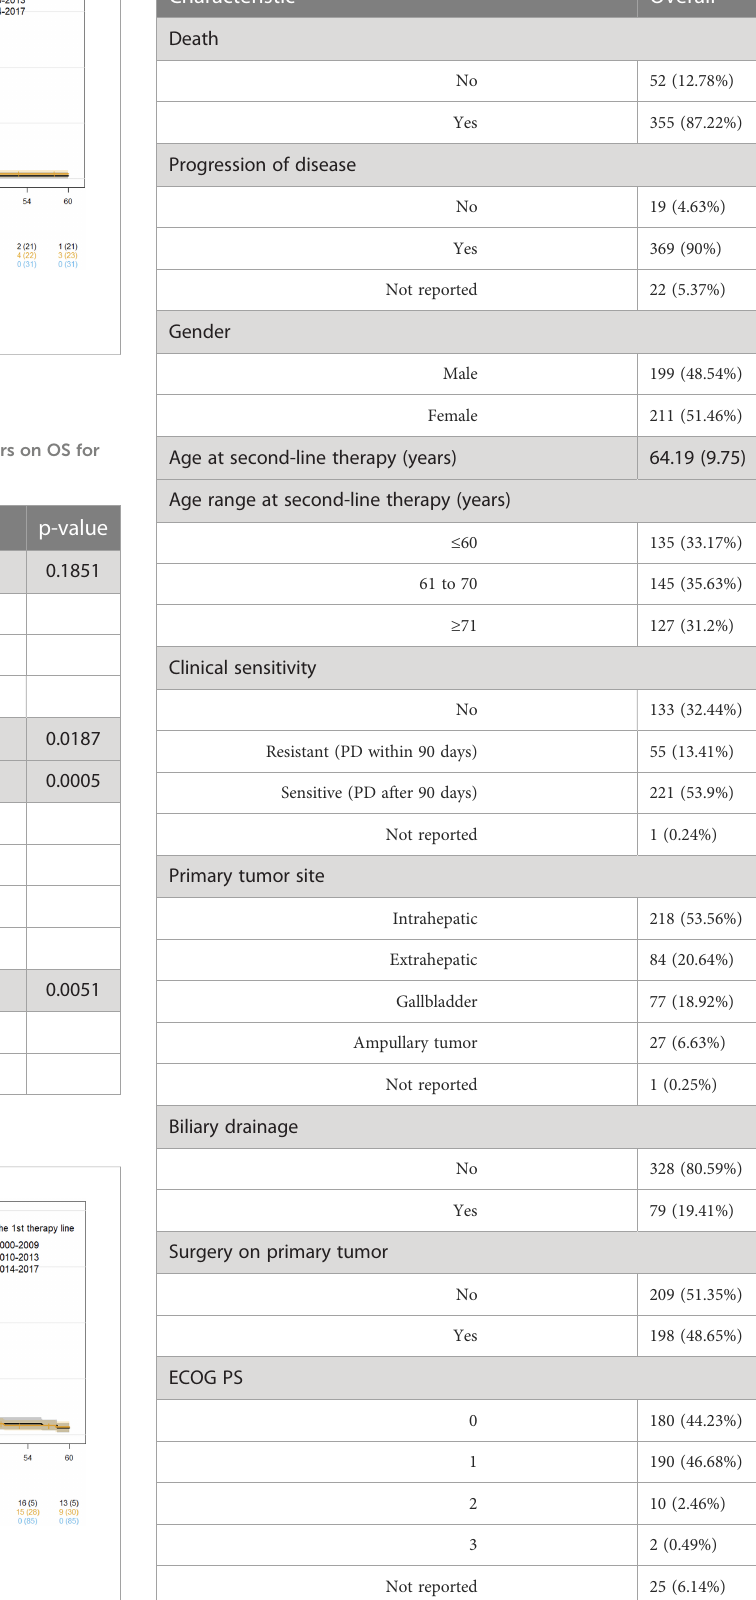
TABLE 5 Demographic and clinical characteristics of study participants undergoing second-line therapy at baseline (n= 410). Characteristic